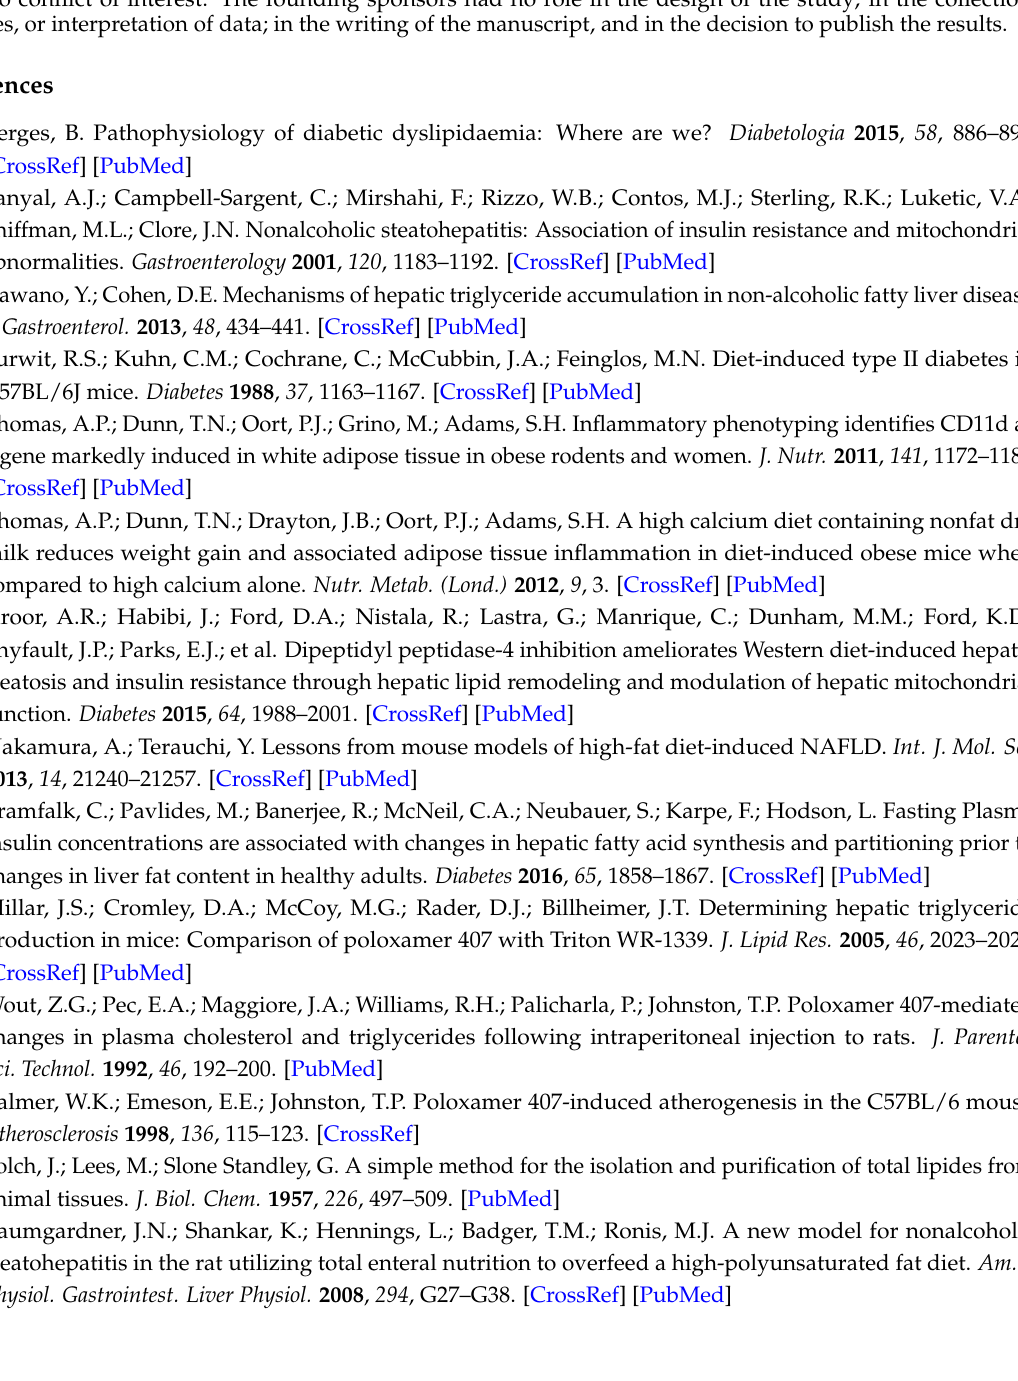
Figure S1: Oil Red O-Stained Liver Sections of male C57BL/6J mice fed low-fat or high-fat diets for 7 weeks (animal identifiers below images; diet information can be found in the